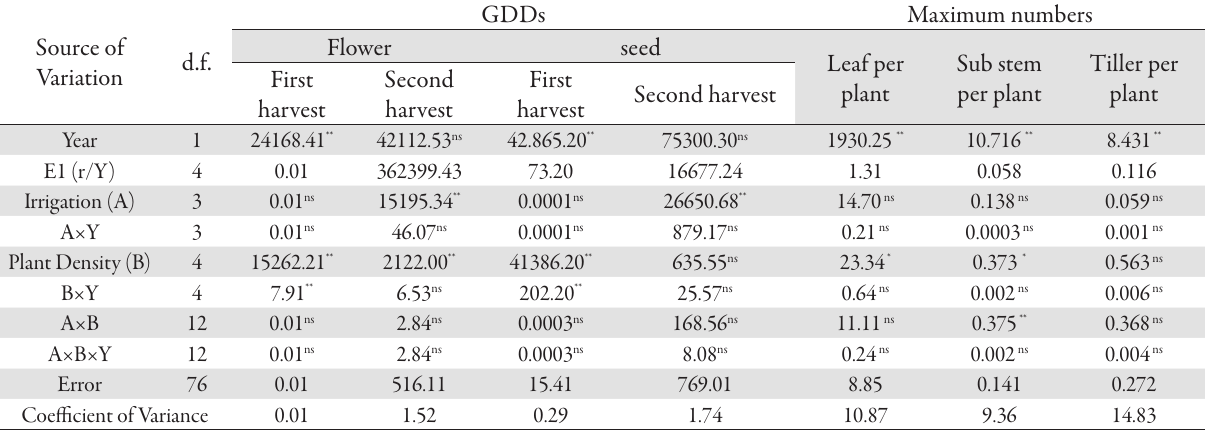
Tab. 4. Combined Analysis of variance of GDDs for flower and seed at two harvest of German chamomile affected by different irrigation regimes and plant densities Source of Variation